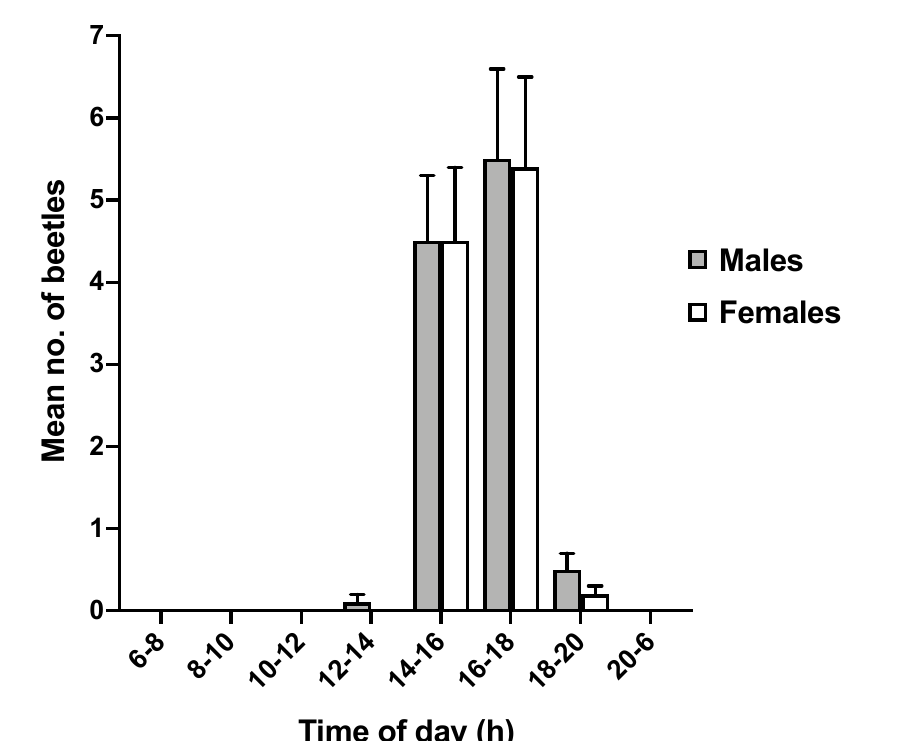
Figure 2. Mean ( ± SE) numbers of adult females and males of Euplatypus parallelus emerged from logs of Khaya senegalensis over different times of day during 19 days of evaluation.